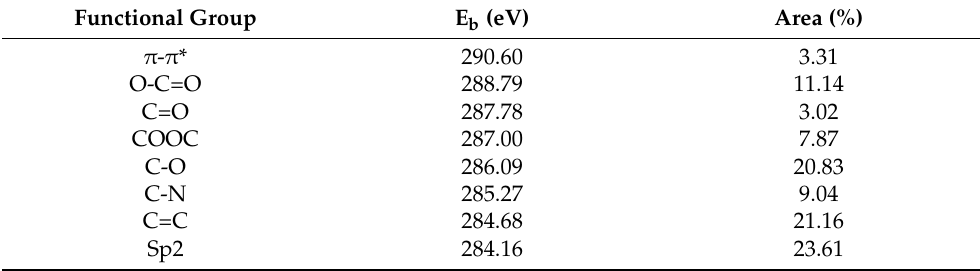
Figure 5. The full-spectrum ( a ), C1s-spectrum ( b ), O1s-spectrum ( c ), and N1s-spectrum ( d ) XPS of water-insoluble gardenia blue pigment. Table 2. The surface functional group content of carbon element (C) of water-insoluble gardenia blue pigment.